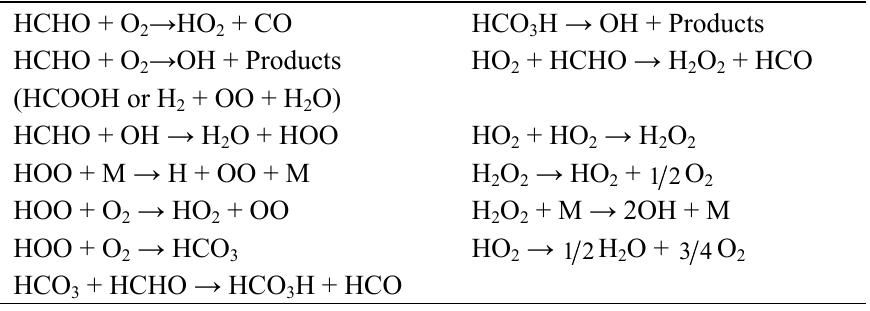
Table 10. Formaldehyde combustion mechanisms proposed by Vardanyan et al. [36], Hay and Hessam [37].